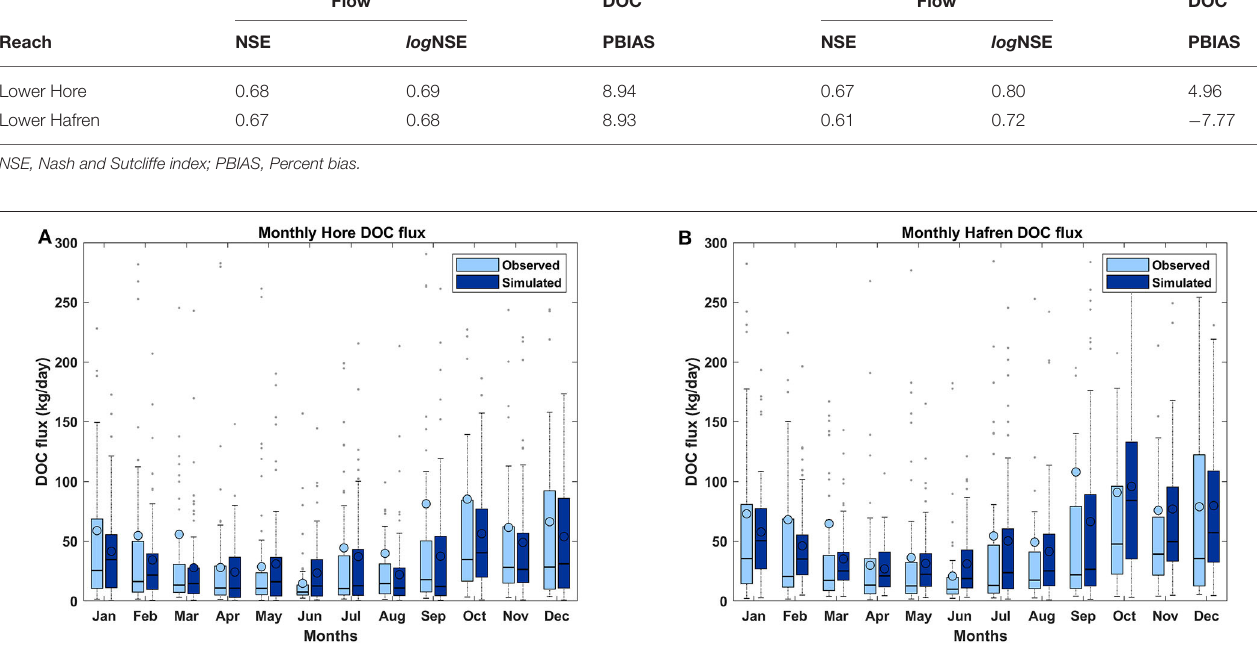
FIGURE 6 | Simulated and Observed Monthly (in-stream) DOC load (kg/day) at Hore (A) and Hafren (B) catchments.